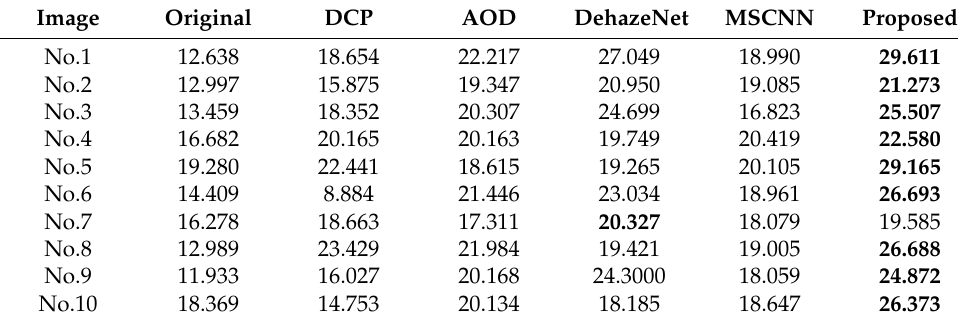
Table 2. Evaluation of processed images by metric PSNR.